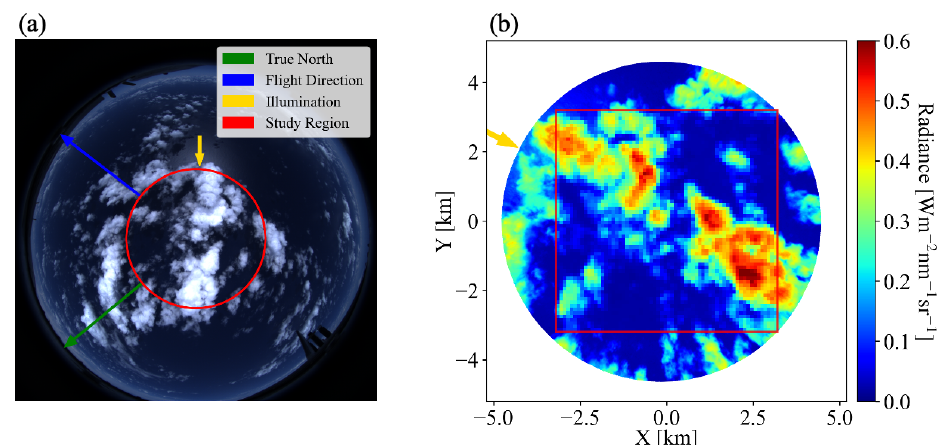
Figure 10. (a) RGB imagery of nadir-viewing all-sky camera deployed during CAMP 2 Ex for a cloud scene centered at 15.2744 ◦ N, 123.392 ◦ E over the Philippine Sea at 02:10:06UTC on 5 October 2019. The arrows indicate true north (green), flight direction (blue), and illumination (where the sunlight comes from, yellow). (b) Red-channel radiance measured by the camera for the circular area indicated by the red circle in (a) . The region in the red square shows a gridded radiance with a pixel size of 64 × 64 and spatial resolution of 100m.